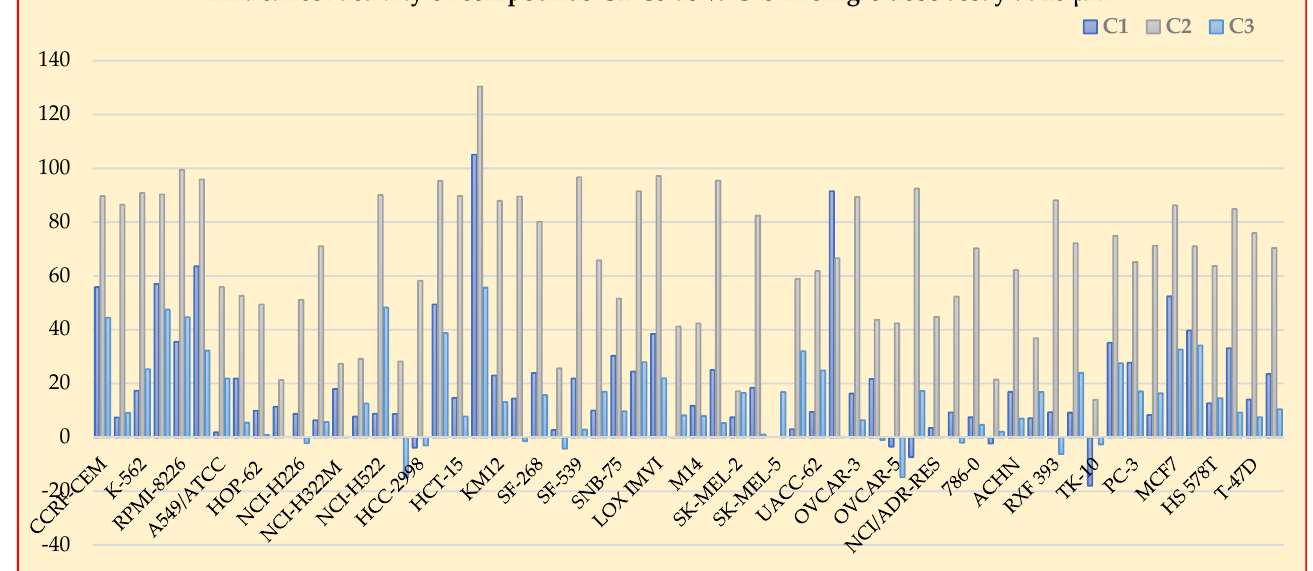
Figure 3. The percent growth inhibition of compounds C1-C3 in single dose assay against 59 NCI cancer cell